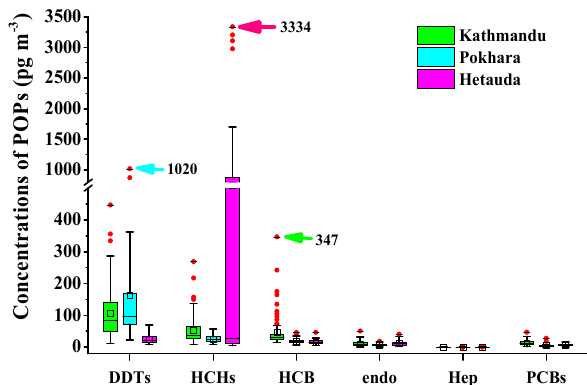
Figure 2. Box-and-whisker plot to show general distribution of POPs in Kathmandu, Pokhara, and Hetauda (lower and upper limits of whiskers indicate minimum and maximum, lower and upper lim- its of the box indicate 25th and 75th percentiles, horizontal line in the box indicates median, small square in the box represents mean, and red circle denotes